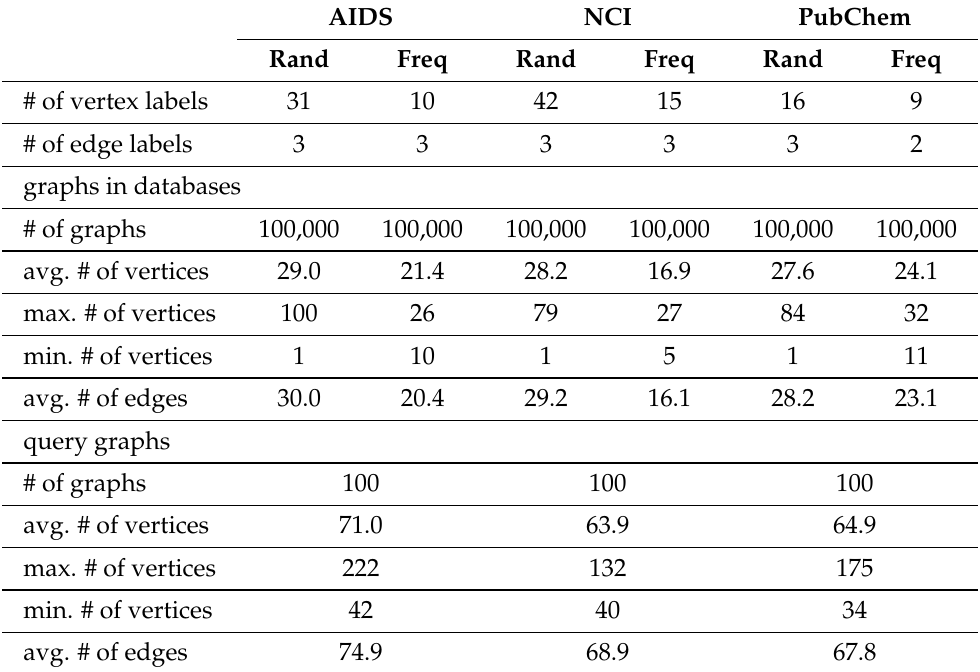
Table 2. Summary of datasets used in our